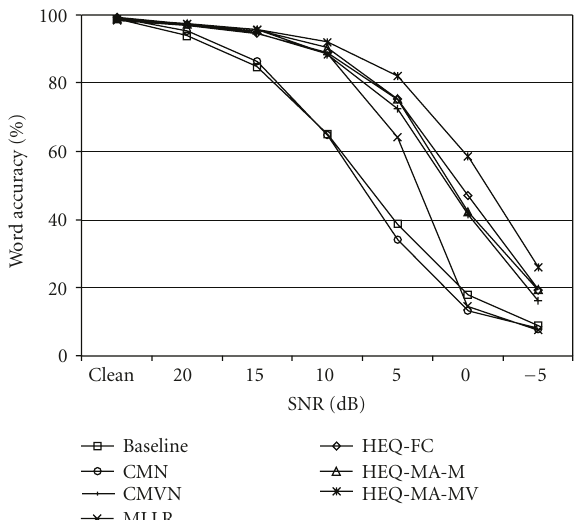
Figure 1: Recognition results on the Aurora2 data at various SNR conditions by the baseline speech recognizer, CMN, CMVN, MLLR, HEQ-FC, HEQ-MA-M (mean-only adaptation), and HEQ-MA- MV (mean and variance adaptation) techniques.